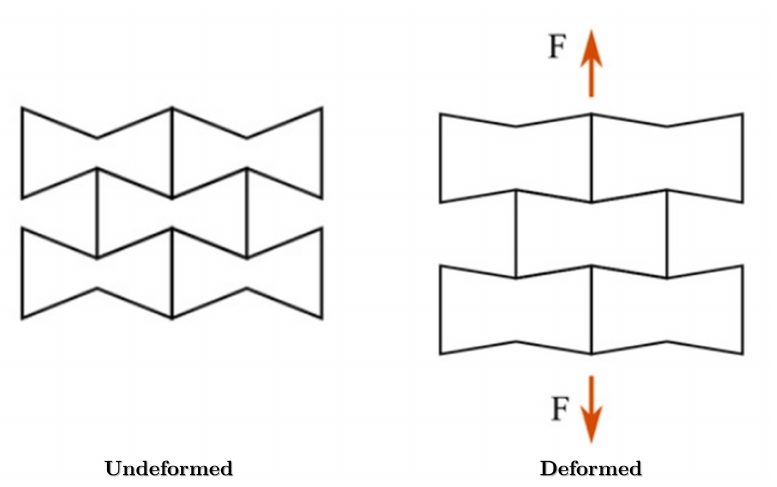
Figure 12. Auxetic behavior of the re-entrant structures. Reprinted with permission from Ref. [122]. Copyright 2022,